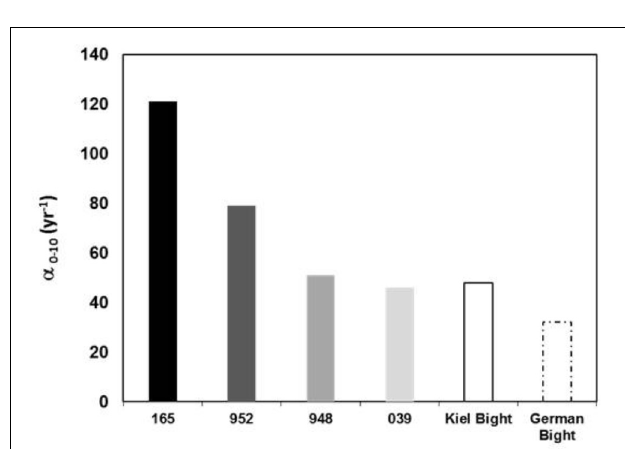
FIGURE 5 | Irrigation rate constants integrated from 0 to 10 cm sediment depth using α 0 and α 1 . Results from this study on Pomeranian Bay are compared to studies employing the same depth dependent analyses of the irrigation rate constant from Kiel Bight (Schlüter et al., 2000) and the German Bight (Forster et al., 2003b) and previous data for